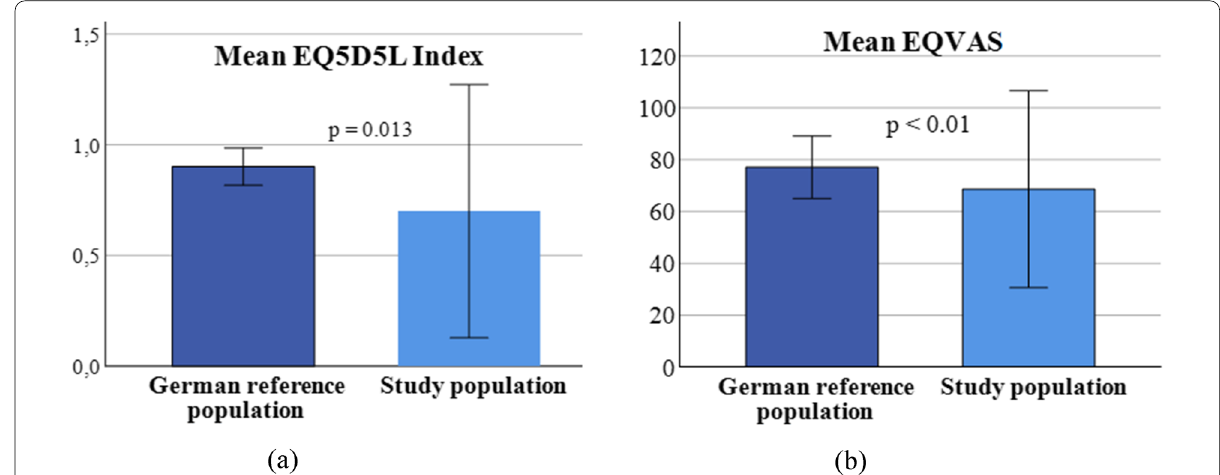
Fig. 3 QoL comparison between study group and German reference population: a mean EQ5D5L index; b mean EQ-VAS. Figure 3 visualizes the differences in objective (EQ5D5L index) and subjective quality of life (EQ-VAS) of the study population and a German reference population